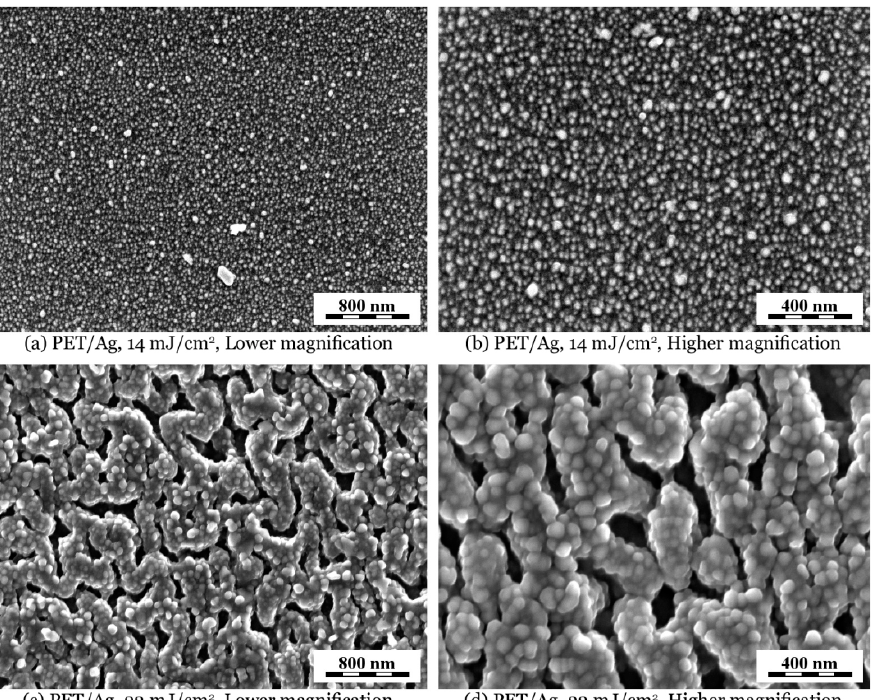
Figure 5. FEGSEM micrographs showing surface morphology of PET immobilized with AgNPs at laser fluencies of 14 and 22 mJ cm − 2 : ( a , b ) smooth PET and ( c , d ) corrugated PET surface. Micrographs were recorded with in-beam SE detector at accelerating voltage 3 kV.